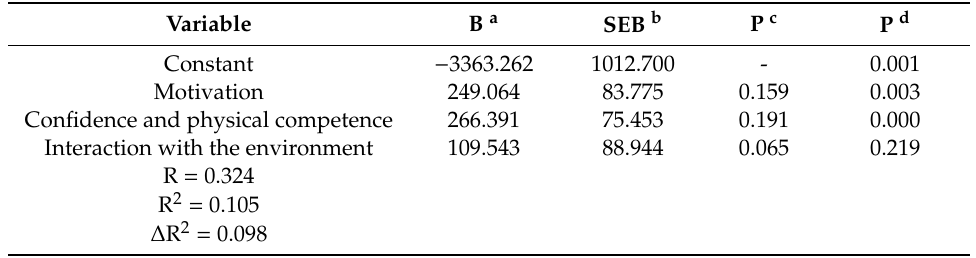
Table 4. Results of multiple linear regression analysis predicting PA level using perceived PL and its dimensions in females ( n = 403).